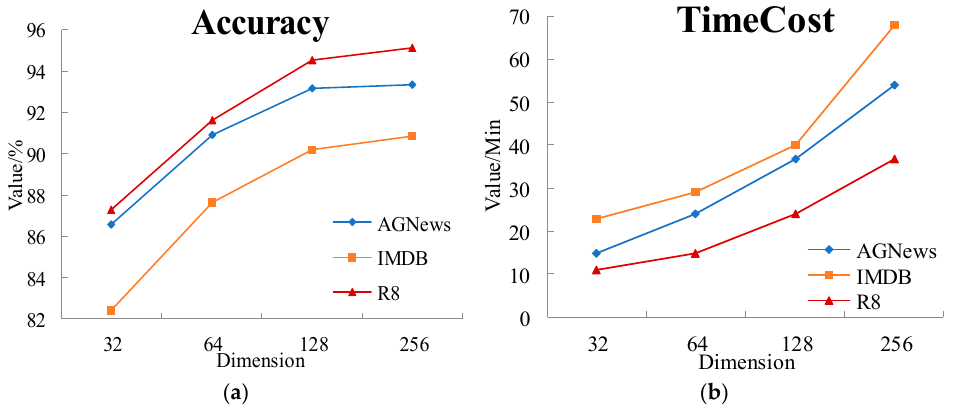
Figure 8. Experimental results for different sizes of the skip-GRU hidden state. ( a ) represents the variation of the accuracy of the SA-SGRU model on the three data sets with the value of the hidden layer; ( b ) represents the average time required by the SA-SGRU model to train epoch 1 on the training set under different dimensions.